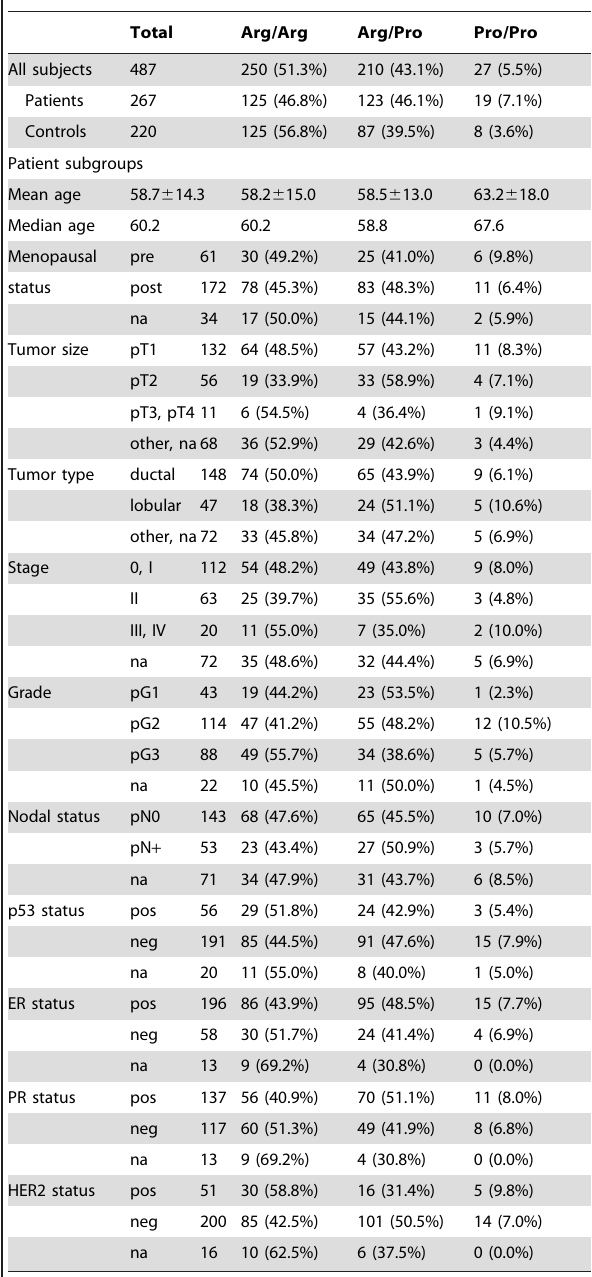
Numbers of patients in each of the indicated subgroups are shown. Numbers in parentheses indicate the fraction of patients (%) in each row with genotypes Arg/Arg, Arg/Pro and Pro/Pro, respectively. na, status not available; ER, estrogen receptor; PR, progesterone receptor. p53 IHC positivity indicates a TP53 mutation [53]. All p-values of subgroup comparisons were . 0.05 (Chi 2 tests).